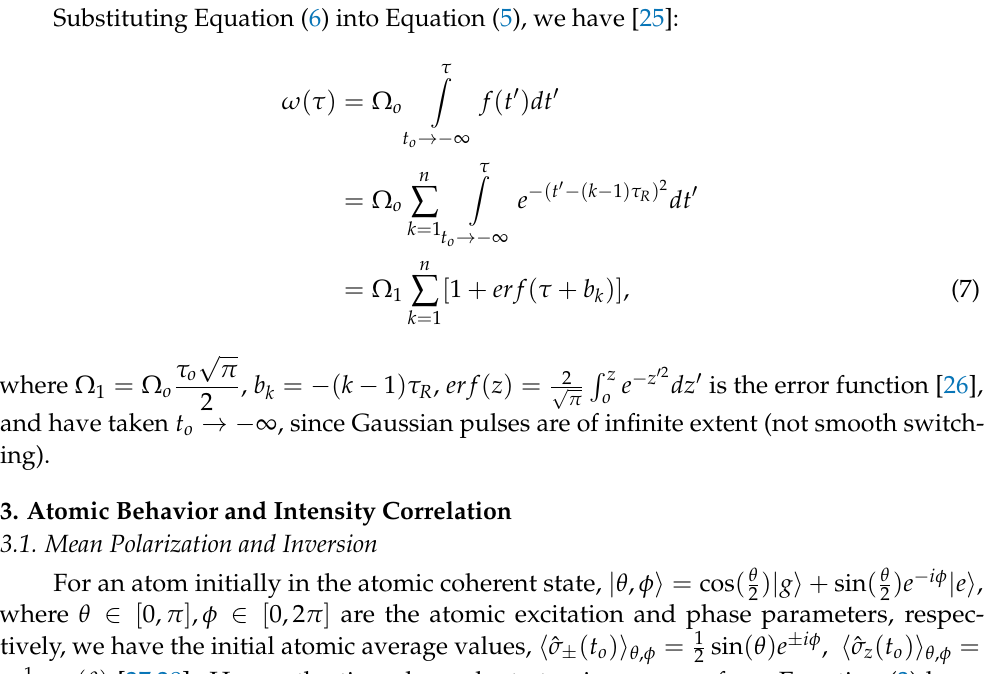
Figure 1. The envelope shape f ( τ ) against τ in the case of n = 4 pulse with different values of τ R